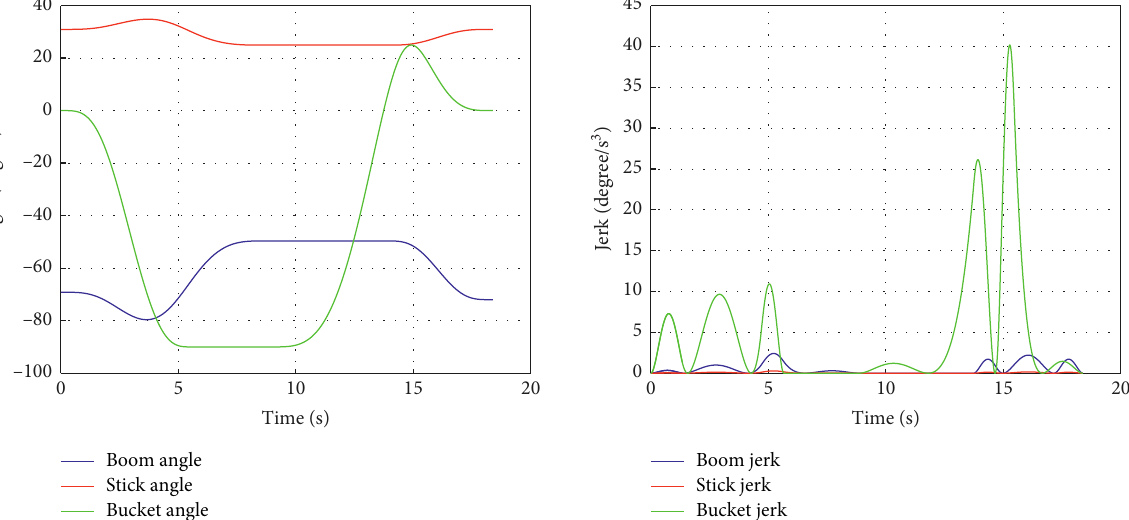
Figure 8: Joint angle and jerk with k